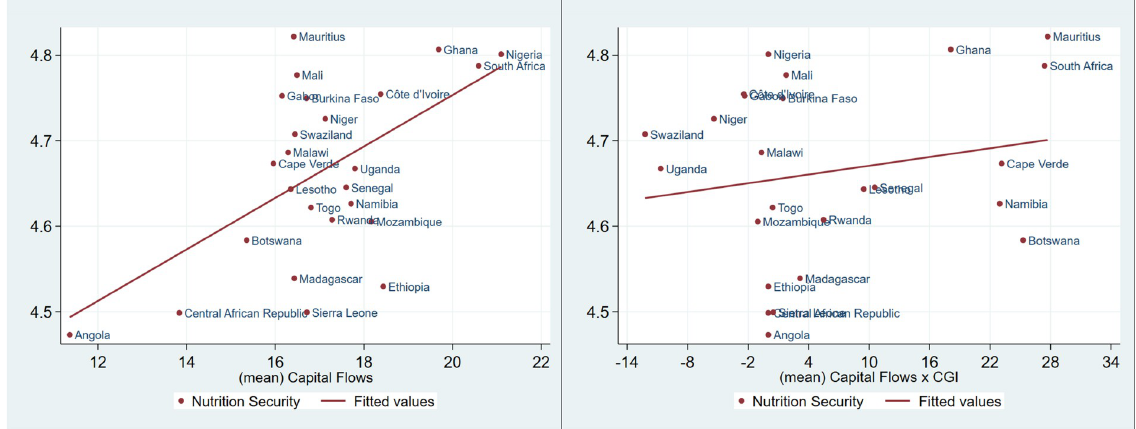
Fig 2. Nutrition security, capital flows and the interaction of governance and capital flows in SSA (1996 to 2018). Source: Authors’ analysis from FAOSTAT, WGI and WDI.